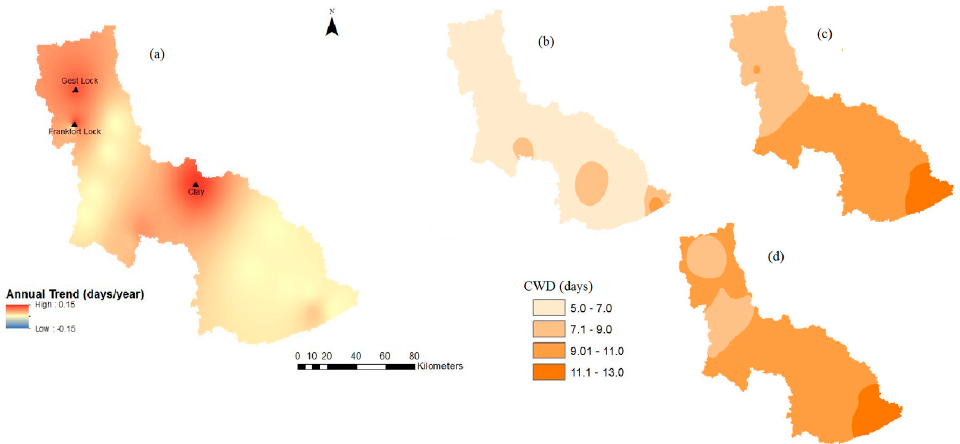
Figure 7. Spatial distribution of CWD ( a ) trend and mean values under: ( b ) baseline; ( c ) late ‐ century RCP 4.5; and ( d ) late ‐ century RCP 8.5, in the Kentucky River Basin. Filled triangles indicate a statistically significant ( p < 0.05) trend.